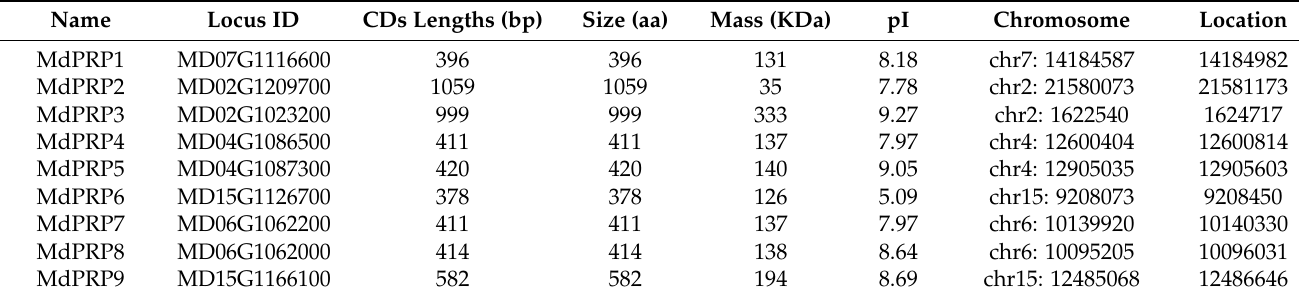
Table 1. List of identified PRP genes in Malus domestica with their detailed information.